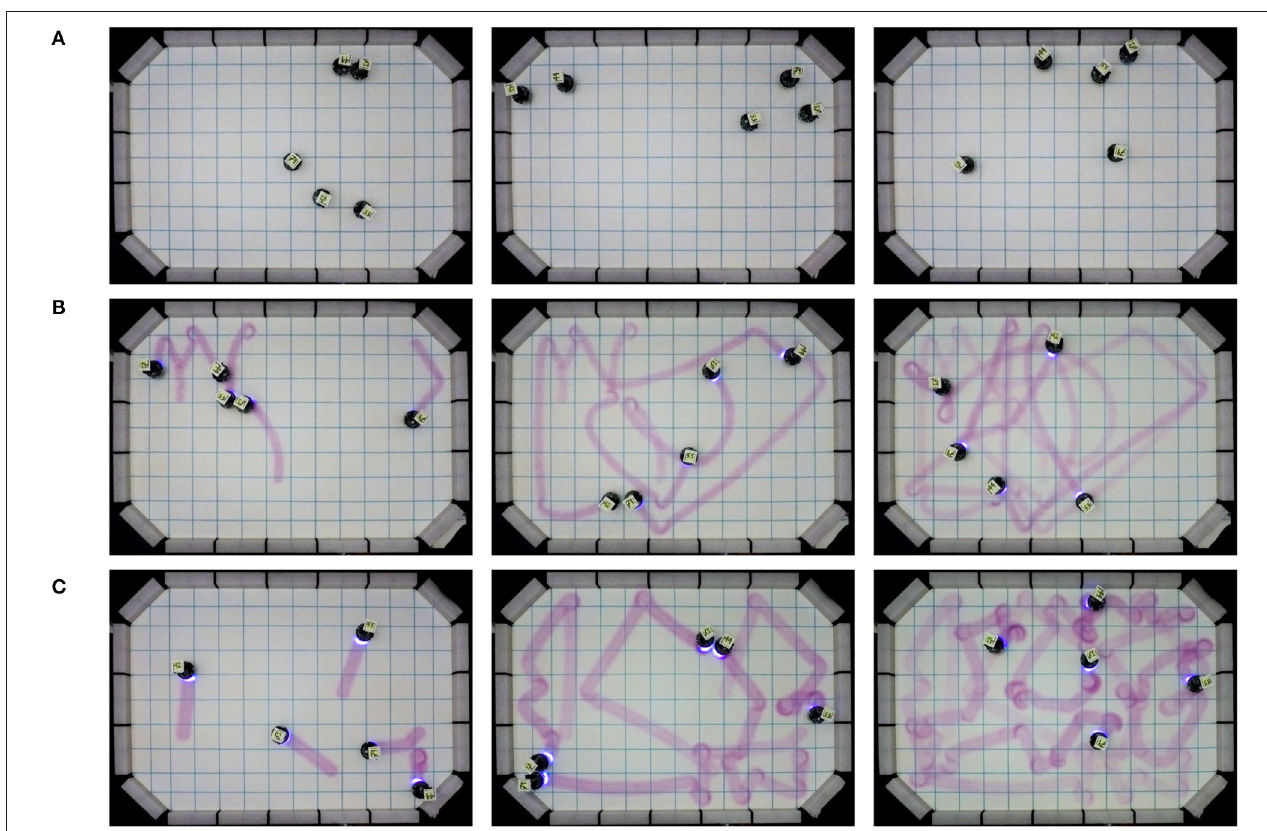
FIGURE 11 | Motion patterns emerged during different COVERAGE experiments. (A) e-puck robots performing Basic- COVERAGE : robots tracking is impossible without an external infrastructure. (B) Robots performing Basic- COVERAGE , they use Phormica only to release pheromone. (C) Robots performing Phormica - COVERAGE : they release pheromone and are also stimulated by its presence.